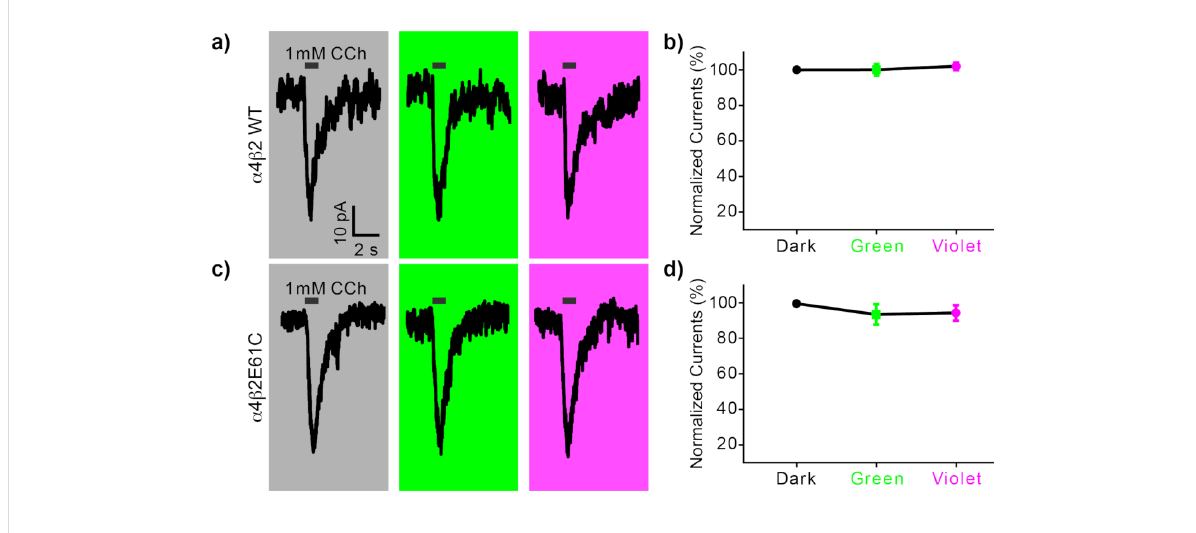
Figure 4: Testing photo-antagonism of 1 with genetically tagged nicotinic acetylcholine receptors. Currents from HEK293 cells were measured using the whole-cell patch-clamp method. Cell were transfected with either wild-type (WT) α 4 β 2 or mutant (E61C) nicotinic acetylcholine receptors [16]. Cells with successful ion channel expression co-expressed YFP visualized using epi-fluorescence microscopy. Cover slips were treated with all trans - 1 (0.05 mM in physiological buffer) for 20 min in the dark. The cellular bathing solution was then exchanged for normal buffer before patch clamping. Currents were evoked by local puffing of the agonist carbachol (CCh, 1 mM, black bar). a) Representative currents from WT receptors before illumination (grey), followed by green light (530 nm, 3 mW, 2 min) or violet light (405 nm, 10 mW, 2 min). Irradiation started 100 s prior to puffing and ended 20 s after puffing. b) Summary of four experiments as in (a). Current amplitudes were normalized to the currents in the dark. Data are the mean ± s.e.m, n = 4 cells. c) Representative currents recordings from identical experiments to those on WT channels carried out on mutant re- ceptors. d) Summary of the currents from six cells. Current amplitudes were normalized to the currents in the dark. Data are the mean ± s.e.m, n = 6